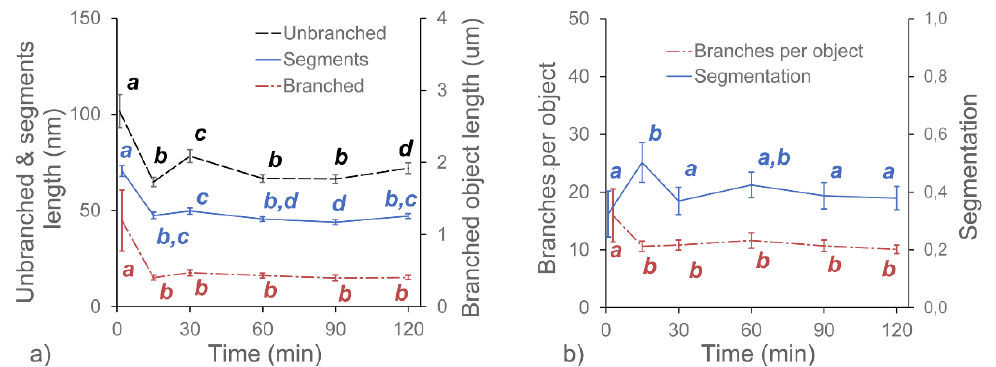
Figure 3. Changes in the average values of the structural parameters of DASP treated with GAL with respect to the duration of enzyme treatment. Different letters indicate significant differences (according to ANOVA with p = 0.05). Bars indicate 95% confidence intervals for mean values.